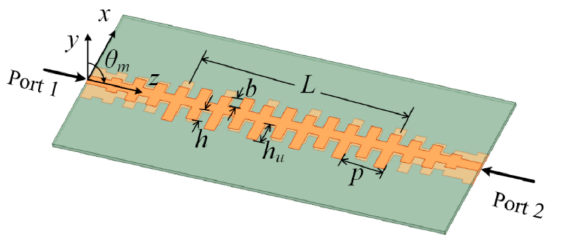
Figure 4. The structure of the proposed antenna with uniform stubs. p = 12 mm, h = 4 mm, b = 3 mm, h u = 6 mm.